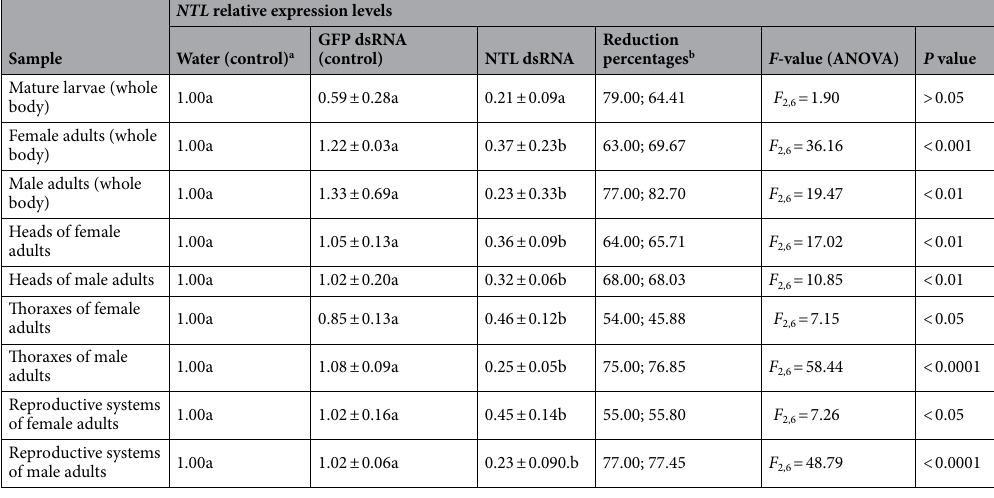
Table 2. Relative expression levels of the S. litura NTL in RNAi treated mature larvae and adults. a Water treated insects were used as calibrators. For each parameter (in each line), values with different letters are significantly different ( P < 0.05). b The first value is the Reduction Percentage relative to Water, and the second value is the Reduction Percentage relative to GFP